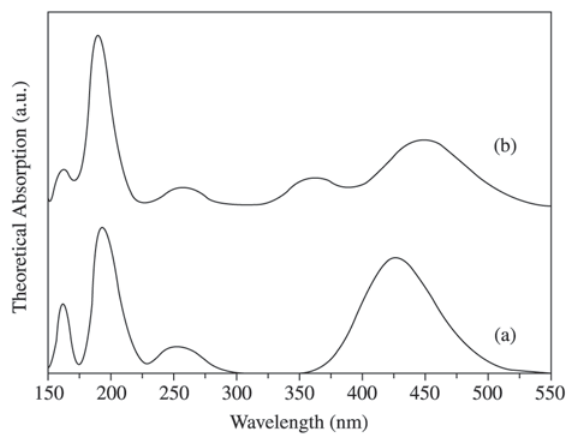
Figure 4. Theoretical absorption spectra. (a) CV + and (b) MG + molecules by INDO/S-CI using the semiempirical method calcu- lated for optimized